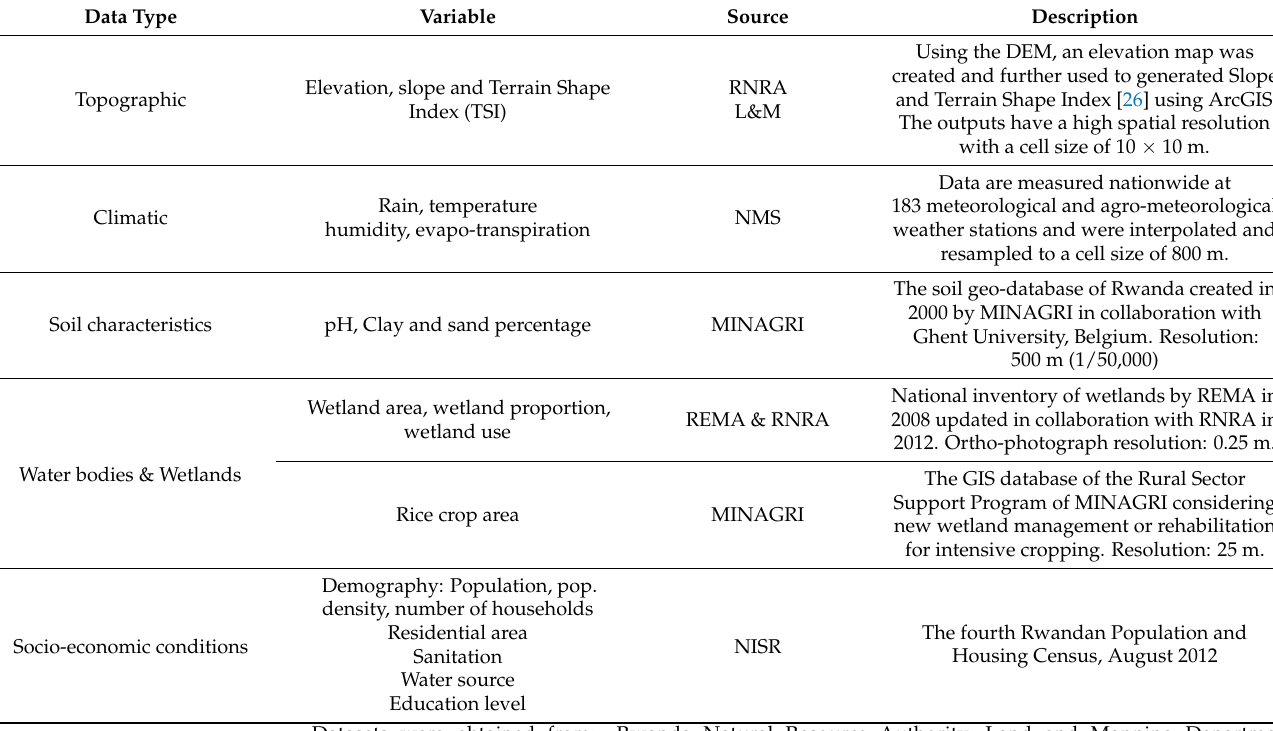
Table 1. Environmental risk factors used to assess the relationships with STH